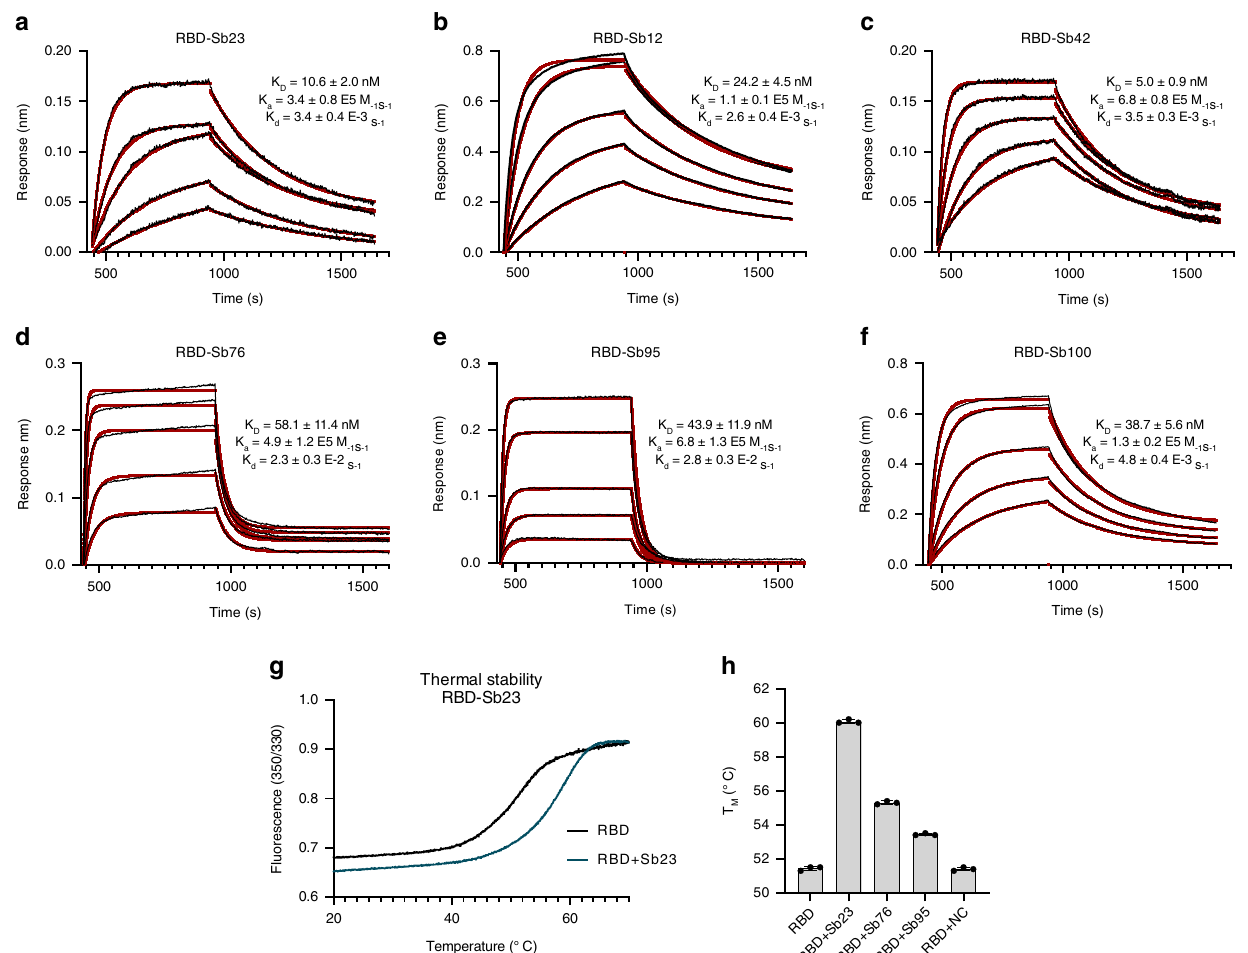
Fig. 2 Biophysical characterization of identi fi ed sybodies. BLI sensorgrams of immobilized SARS-CoV-2 RBD with 2-fold serial dilution of 75 nM Sb23 ( a ), 188 nM Sb12 ( b ), 50 nM Sb42 ( c ), 250 nM Sb76 ( d ), 250 nM Sb95 ( e ), and 188 nM Sb100 ( f ). Binding curves are colored black and the global fi t of the data to a 1:1 binding model is red. Resulting af fi nities are indicated. g Thermal unfolding data of isolated RBD and in complex with Sb23. h Resulting melting temperatures of RBD alone and in complex with Sb23, Sb76, Sb95, and a control sybody (NC), selected against the human peptide transporter (hPepT2). Data represent the mean ± SD of three replicate